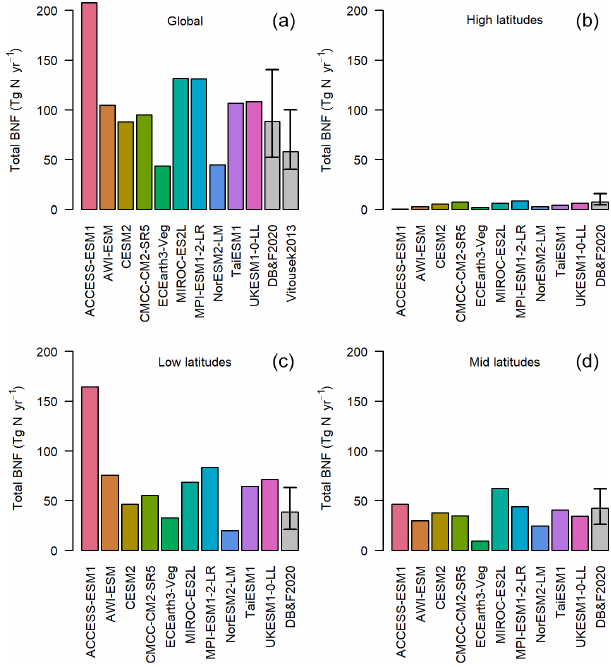
Figure 1. The global total annual BNF (TgNyr − 1 ) for the aver- age of the period 1980–2014. The grey bars represent the obser- vationally constrained ranges by Davies-Barnard and Friedlingstein (2020) and Vitousek et al. (2013). The four panels represent latitude bands and global. High latitudes: more than 60 ◦ N or 60 ◦ S. Mid- latitudes: less than 60 ◦ N and more than 30 ◦ N, less than 60 ◦ S and more than 30 ◦ S. Low latitudes: less than 30 ◦ N and less than 30 ◦